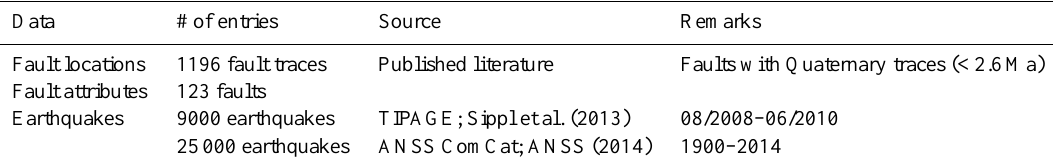
Table 1. Overview of the data sets used in the CAFD.